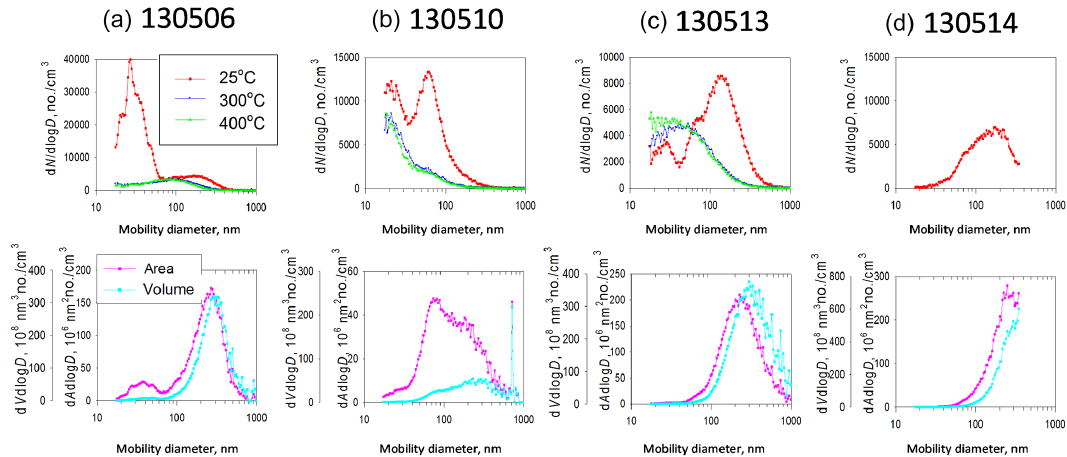
Figure 5. Number- (upper panels), cross-section-area-, and volume-based (lower panels) size distributions of aerosol particles during the sampling of samples A–D, as measured by SMPS. Red lines in the upper panels represent the number-based size distributions for particles measured without passage through the TD, while blue and green lines represent those for particles measured after passage through the TD maintained at 300 and 400 ◦ C,